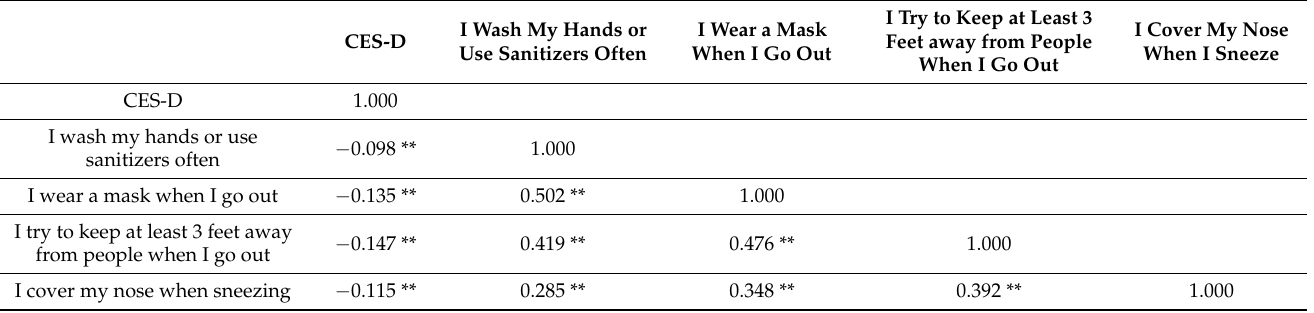
Table 4. Correlations between depressive symptoms and adherence to precautionary measures among female undergradu- ates ( n = 1883).